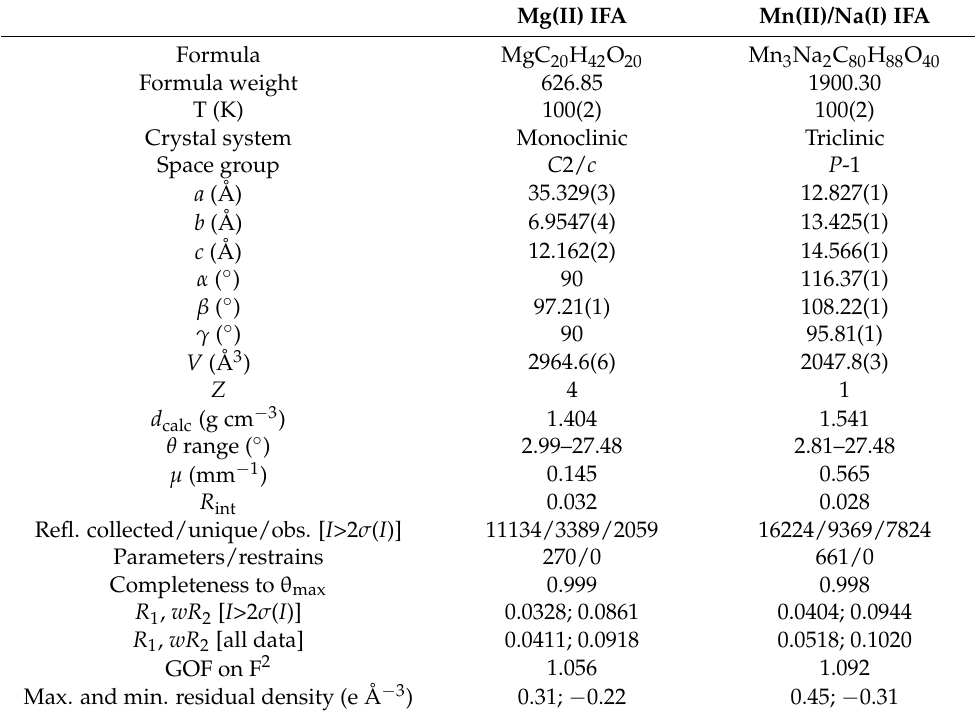
Table 2. Crystallographic data and final structure refinement details for the studied